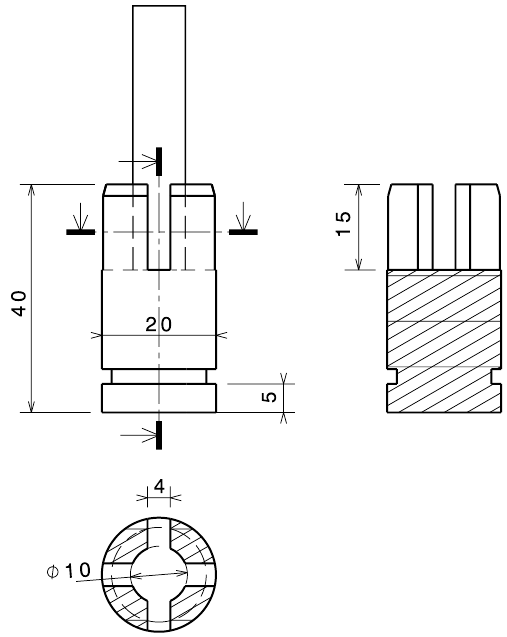
Figure 8. Dimensions of the sabot for the Taylor